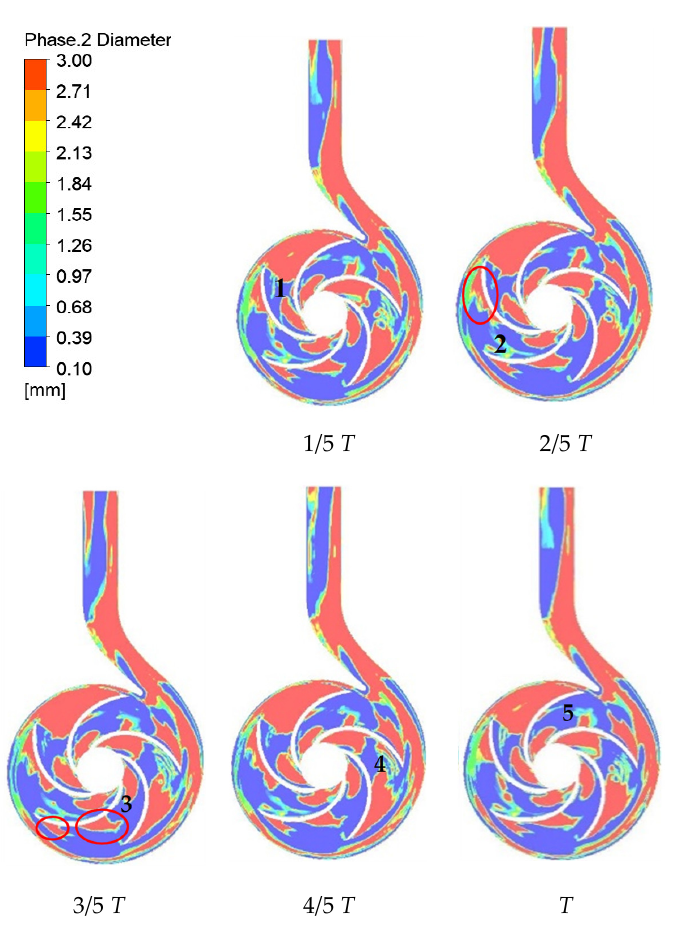
Figure 11. Cloud of bubble diameter distribution in one complete cycle under IGVF = 3%.